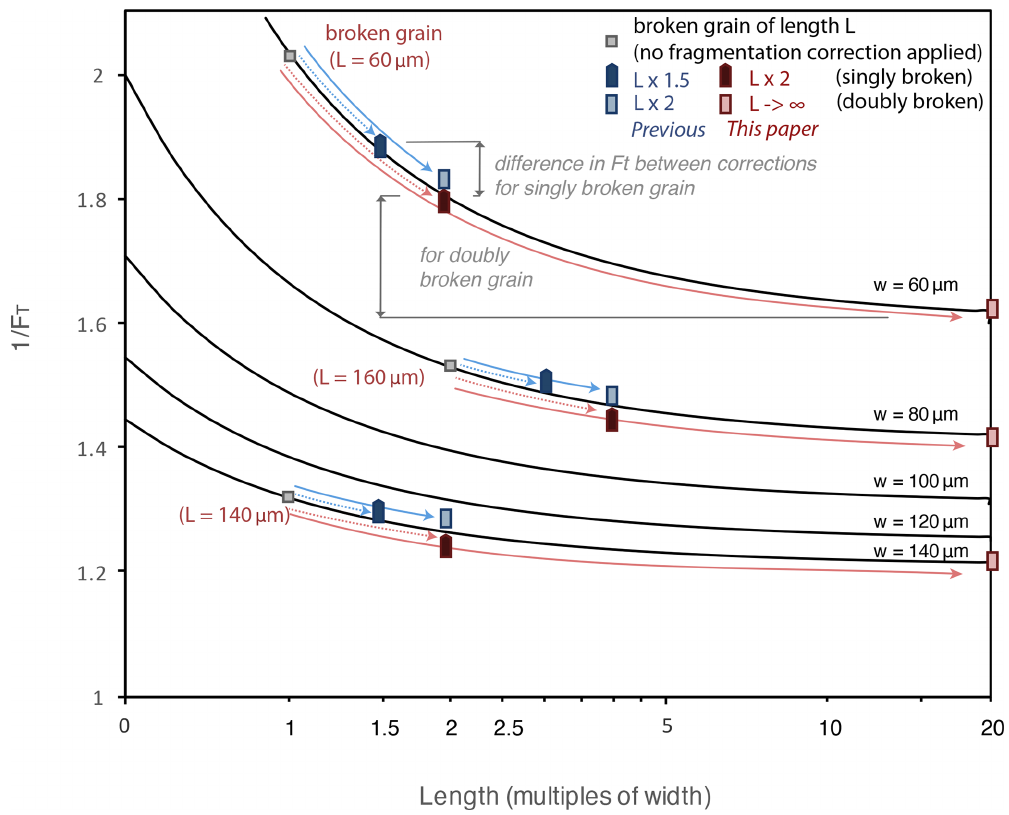
Figure 3. The inverse of the F T value plotted as a function of crystal length L , as used in the calculation of β or β α . For a broken crystal, this is measured parallel to the c axis (as a multiple of width) and modified by some factor (see legend). The inverse of F T can be approximately considered a multiplier for the raw date, where corrected date ≈ raw date × (1 /F T ) (Farley et al., 1996). Inverse F T corrections for three example fragments are shown (width = 60, 80, and 140µm and length = 60, 160, and 140, respectively) with the corresponding fragment- corrected F T values for singly or doubly broken crystals. The gray squares indicate the actual length of the fragment and show their inverse F T values if no fragmentation correction is applied. For convenience, the asymptotic value is assumed to be approximately the same as multiplying by some large number (e.g., 20). Note that, strictly speaking, the calculation of a corrected date requires using the full decay equation with an individual F i for each nuclide, rather than the simplification of corrected date ≈ raw date × (1 /F T T